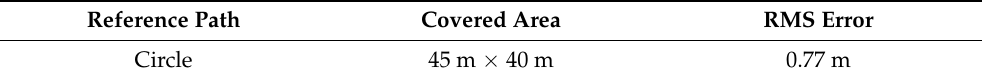
Table 6. The positioning results of the proposed H 2 estimation design in the simulation.